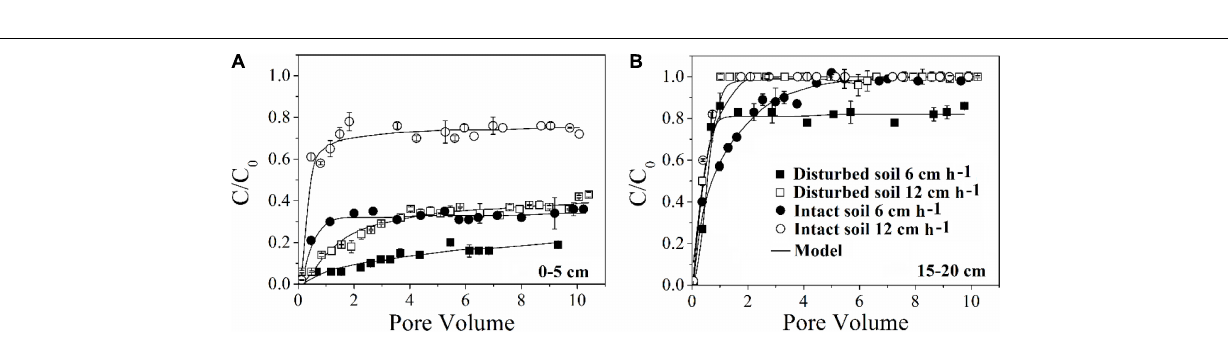
FIGURE 1 | Effect of pore water velocity (6 and 12 cm h − 1 ) on the transport of bromide and E. coli 652T7 through the intact soils at different depths of (A) 0–5 cm, (B) 5–10 cm, (C) 10–15 cm, and (D) 15–20 cm.